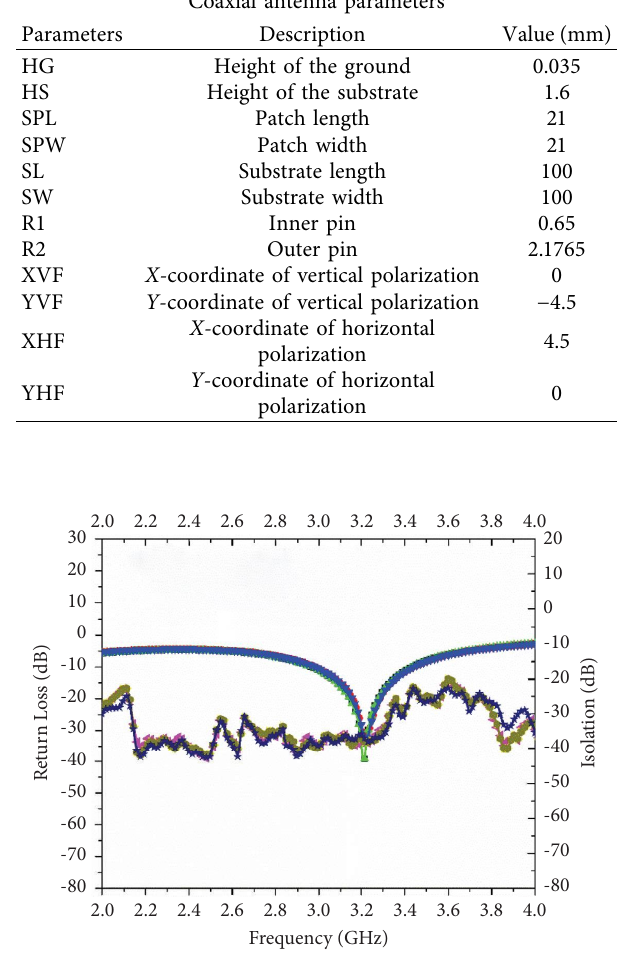
Figure 1: Airborne synthetic aperture radar geometry.